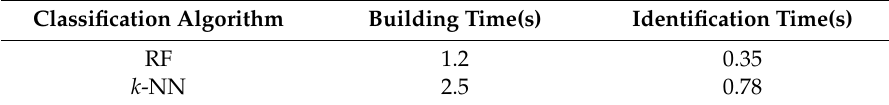
Table 2. The comparison of data processing time.